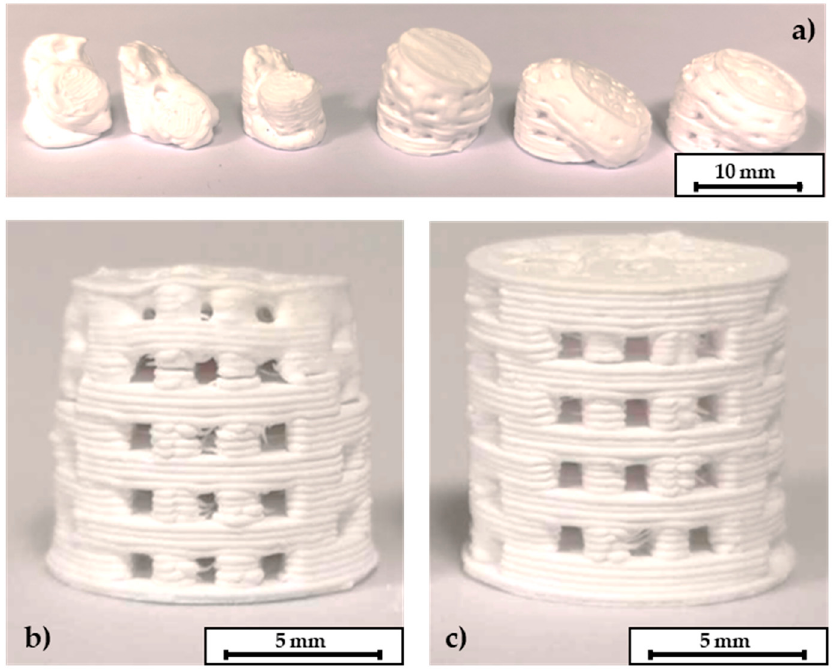
Figure 7. C3 based scaffolds. ( a ) P1 program without a surrounding powder bed leads to destruction of the components. ( b ) P2 program without a powder bed and ( c ) debinding within a powder bed. The layer thickness of these scaffolds was 0.25 mm, height of the scaffolds 10 mm, pore size 1 mm × 1 mm.